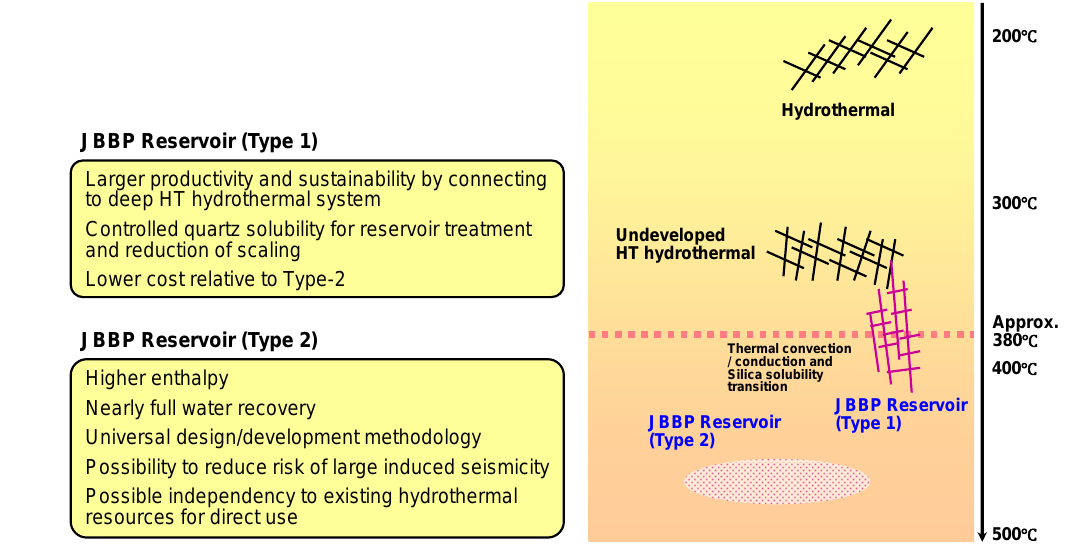
Figure 1. Two possible types of JBBP